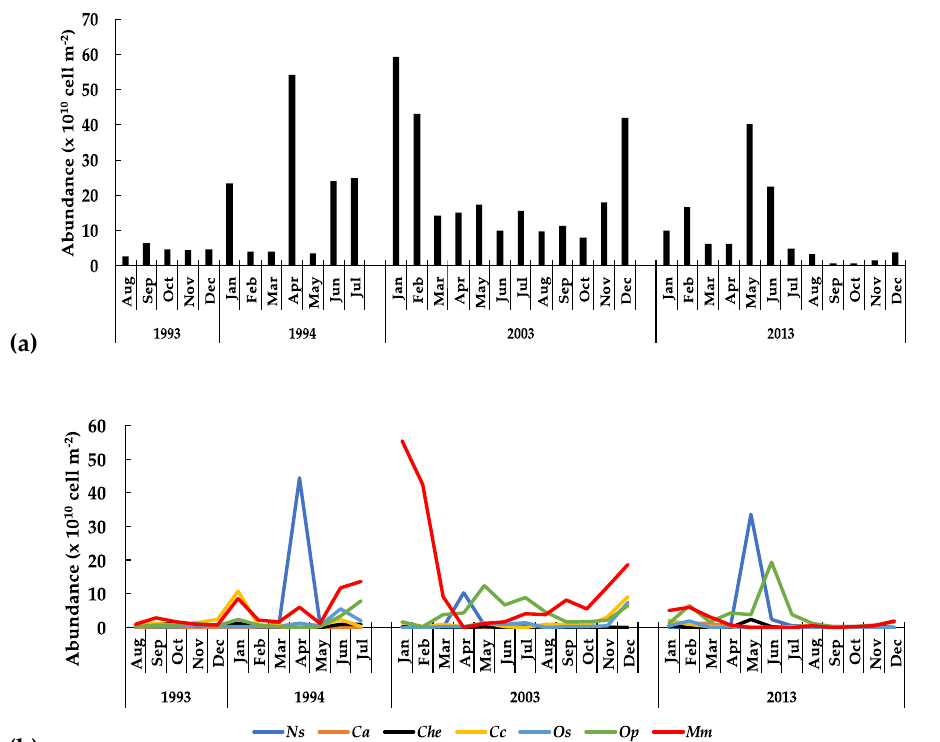
Figure 10. Temporal dynamics of ( a ) total phytoplankton and ( b ) per species abundance in Lake Alchichica during 1993–1994, 2003, and 2013. ( Mm : Monoraphidium minutum , Op : Oocystis parva , Ns : Nodularia aff. spumigena , Cc : Cyclotella choctawhatcheeana , Os : Oocystis submarina , Che : Chaetoceros elmorei , Ca : Cyclotella alchichicana ).